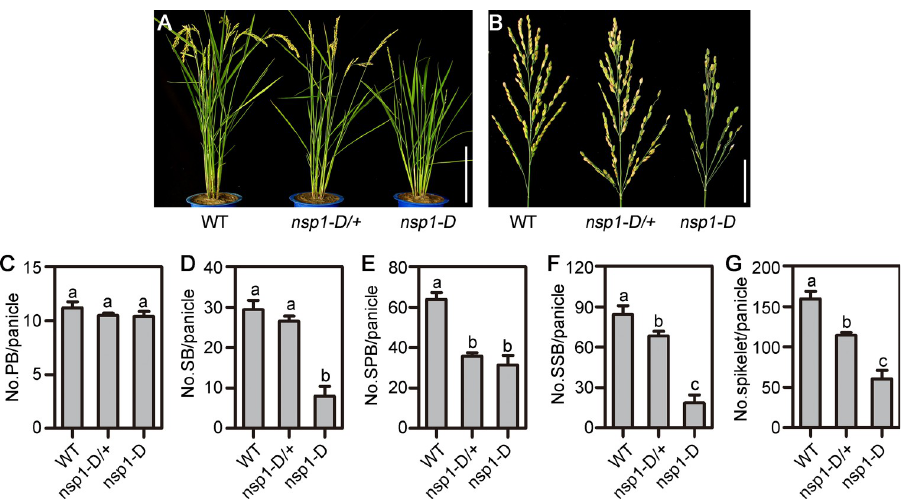
Fig 1. Characterization of the no spikelet 1-Dominant ( nsp1-D ). (A) and (B) Architecture of plant (A) and panicle (B) in wild type (WT), nsp1-D/+ , and nsp1-D during reproductive growth. Bars = 20 cm in (A) and 5 cm in (B). (C) to (G) Statistical analysis of the number of primary branches (PBs) (C), secondary branches (SBs) (D), spikelets in PBs (SPBs) (E), spikelets in SBs (SSBs) (F), and total spikelets (G) per panicle among WT, nsp1-D/+ , and nsp1-D plants. Values shown are the means ± SEM from 10 replicates. Letters denote significant differences as ranked by the Dunnett’s test (one-way analysis of variance, P <